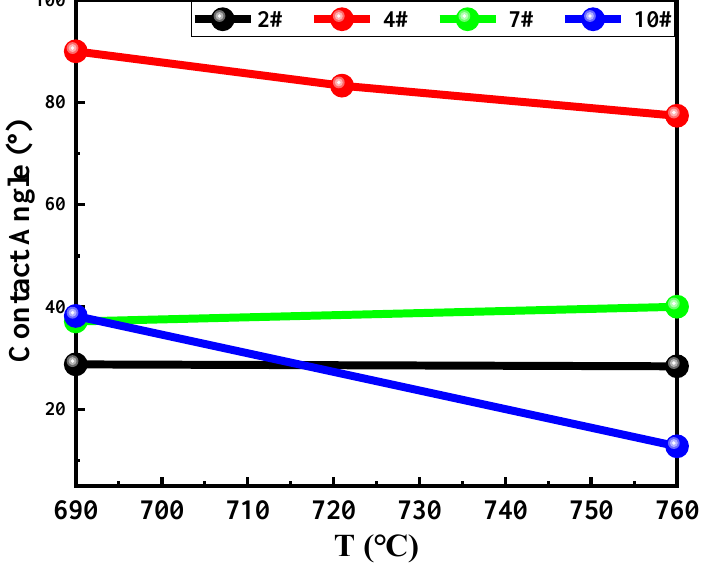
Figure 7. The contact angle of the fluxes with the alumina in the refining temperature range.